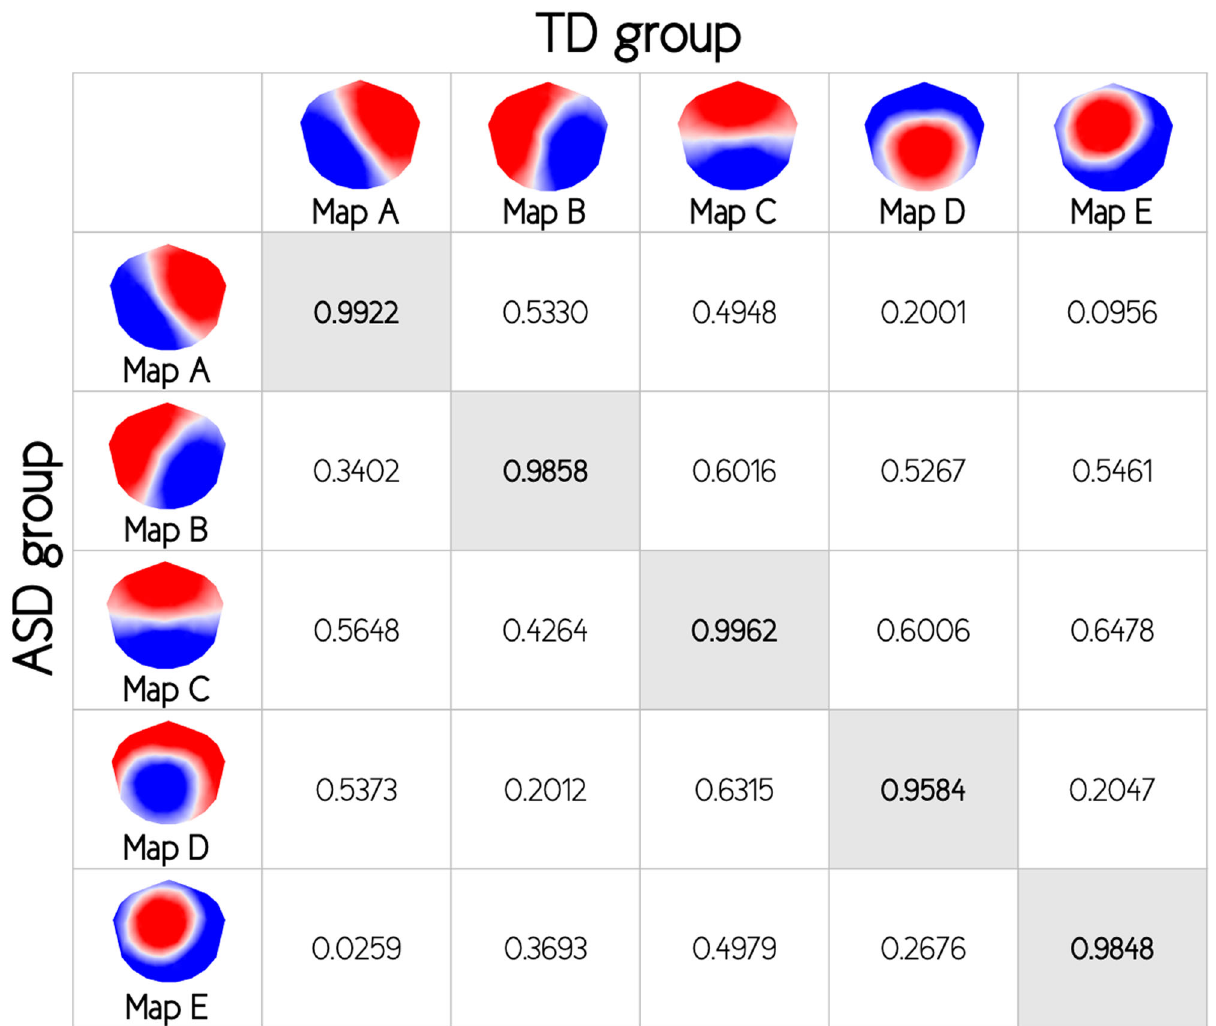
Fig. 2 Spatial correlations between template maps. Values of Pearson ’ s spatial correlations coef fi cients between the 5 template maps of both autism spectrum disorders (ASD) and typically developing (TD)